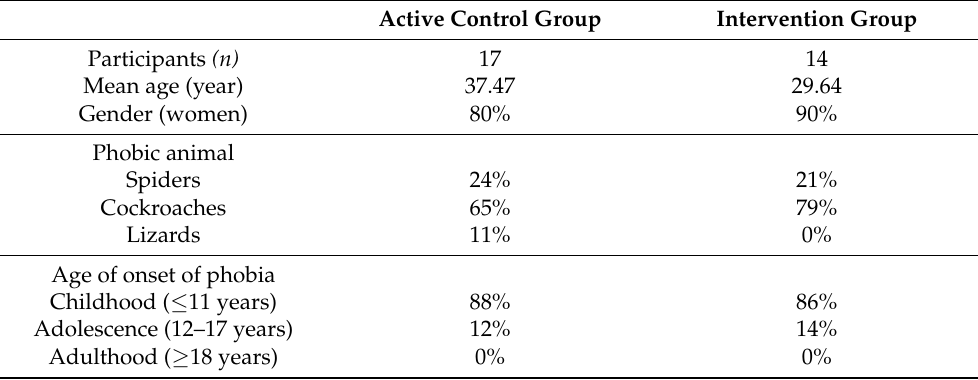
Table 1. Baseline characteristics of